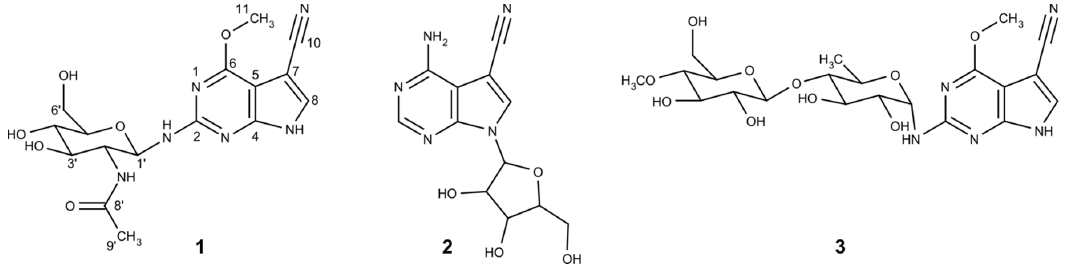
Figure 2. The structures of ( 1 ) huimycin, ( 2 ) toyocamycin, and ( 3 ) dapiramicin A.